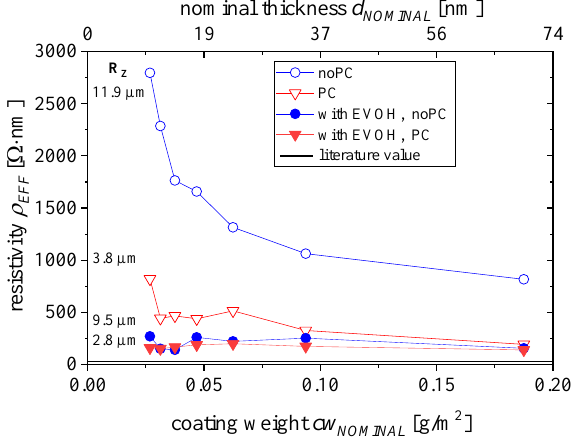
Figure 5. Increasing roughness increased the effective resistivity at 0% relative humidity ( RH ) due to defects in the aluminum coating. Although EVOH coating only had a minor impact on roughness ( R Z ) values, the resistivity decreased massively due to the reduction of the areal density of micropores and channels. Results were generated on Metalkote paper. PC/noPC = paper surface with/without pigment coating. EVOH = ethylene vinyl alcohol lacquer.